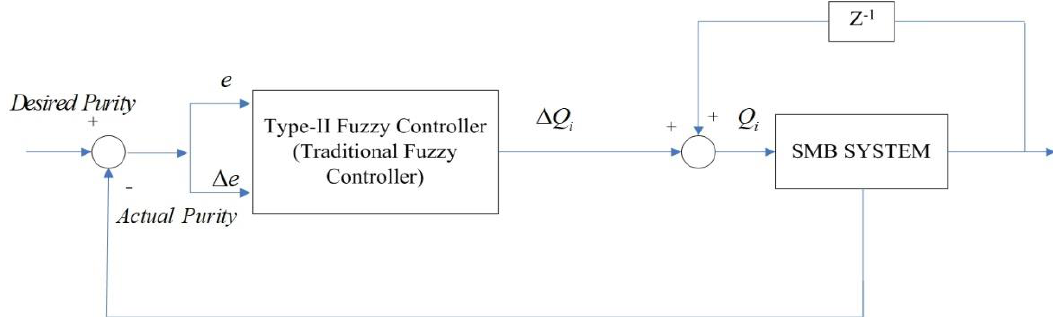
Processes 2022 , 10 , x FOR PEER REVIEW Figure 2. The structure of the SMB control process. For the traditional fuzzy controller, five linguistic variables—namely, NB, NS, ZE, PS, and PB—were defined for both e i ( k ) and ∆ e i ( k ) . NB represented a large negative force, NS represented a medium negative force, ZE represented no force, PS represented a medium positive force, and PB represented a large positive force. The triangular membership function and singleton membership function shown in Figures 3 and 4 were used as the fuzzifier and defuzzifier, respectively. The rule table for the three controllers is listed in Table 3. The singleton values [ a 1 , a 2 , a 3 , a 4 , a 5 ] set for ∆ Q i were ∆ Q 1 = [ − 0.12, − 0.08, 0, 0.08, 0.12], ∆ Q 2 = [ − 0.006, 0.004, 0, 0.004, 0.006], and ∆ Q 3 = [ − 0.08, − 0.05 0, 0.05, 0.008].